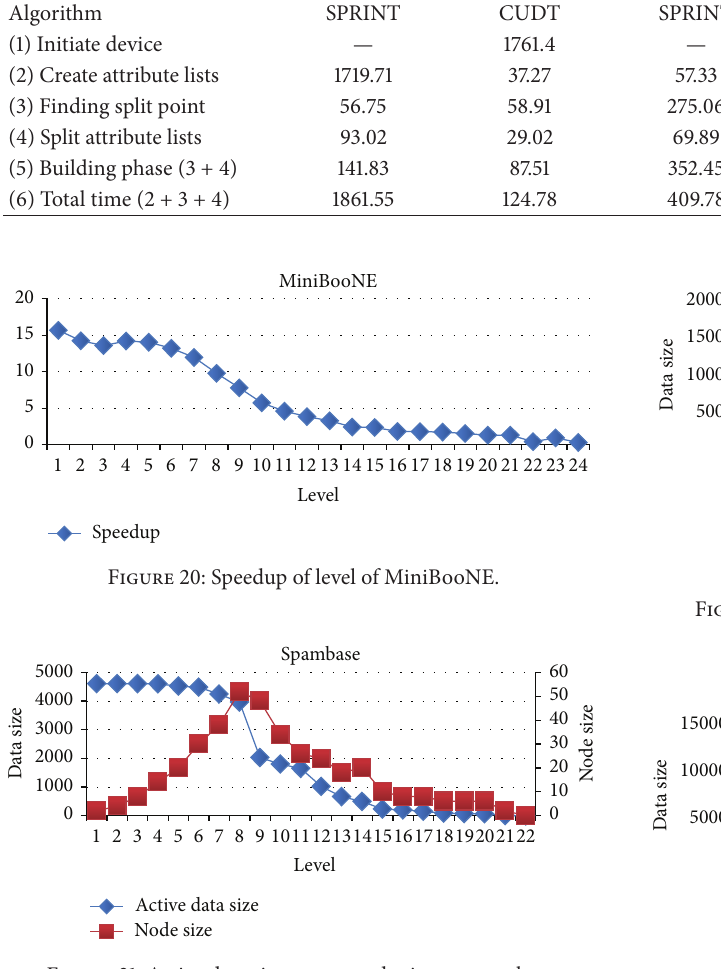
Figure 21: Active data size versus node size on spambase.